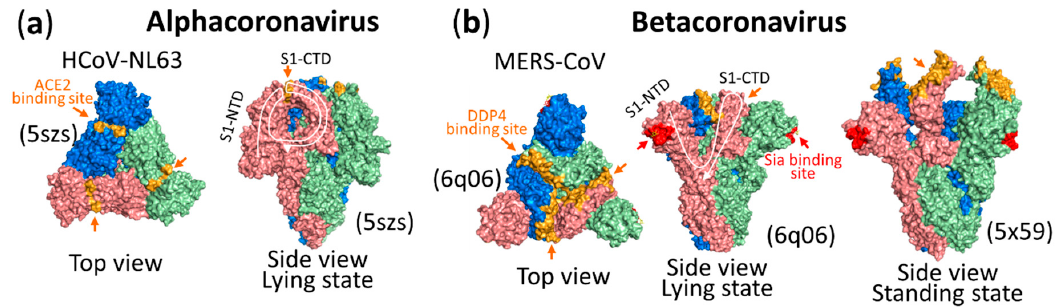
Figure 6. Structural comparison of α CoV and β CoV spike (S) proteins. Top and side views of homotrimeric S proteins, which are colored in salmon, marine and pale green, of α CoV (HCoV-NL63, pdb: 5szs [204]) ( a ) and β CoV (MERS-CoV, pdb: 6q06 [148] and 5x59 [205]) ( b ). Notably, a di ff erence